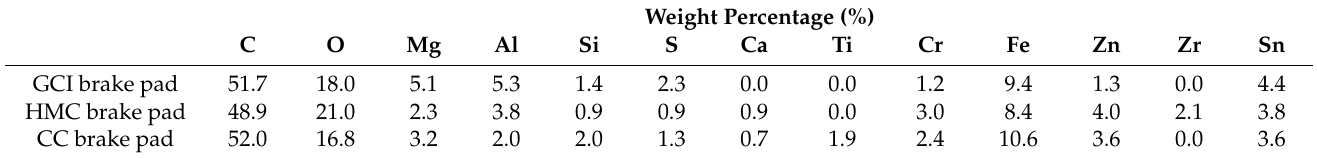
Table 3. Chemical composition of the serial brake pads used (GCI, HMC, CC)—X-Ray analysis (vehicle 1).